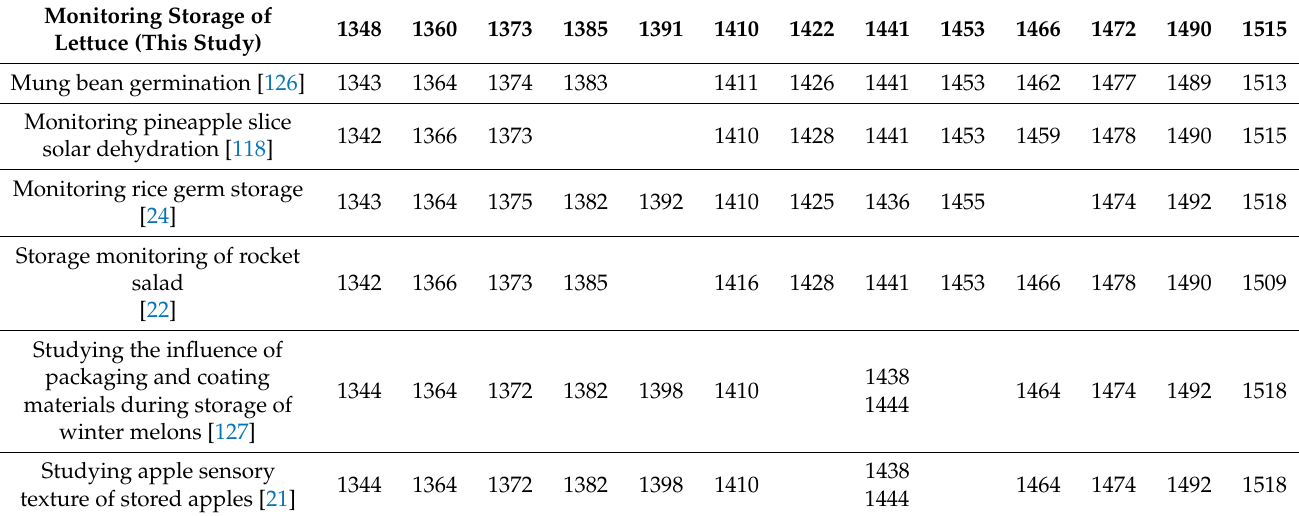
Table 5. Agreement between the WAMACs found for description of changes during